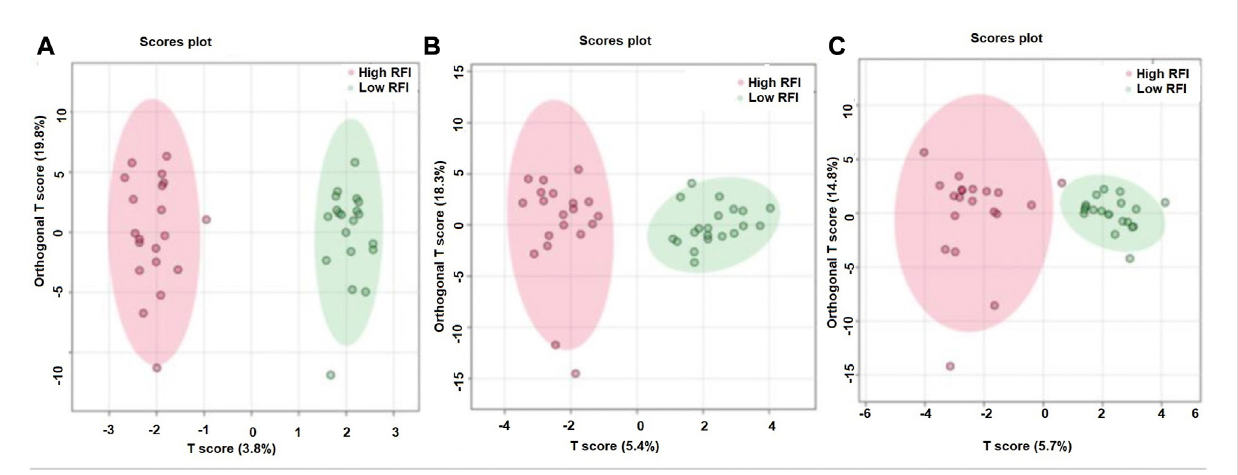
FIGURE 5 Orthogonal partial least squares discriminant analysis showing a clear separation between the least and most ef fi cient cows at early (A) , mid (B) and late (C) lactation stages.